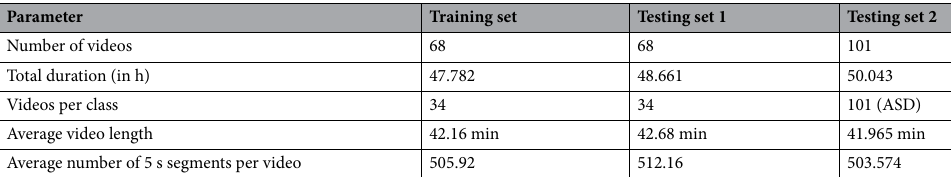
Table 2. Representation of video characteristics included in the Training and Testing set 1 as well as Testing set 2 used to validate the robustness of neural network derived